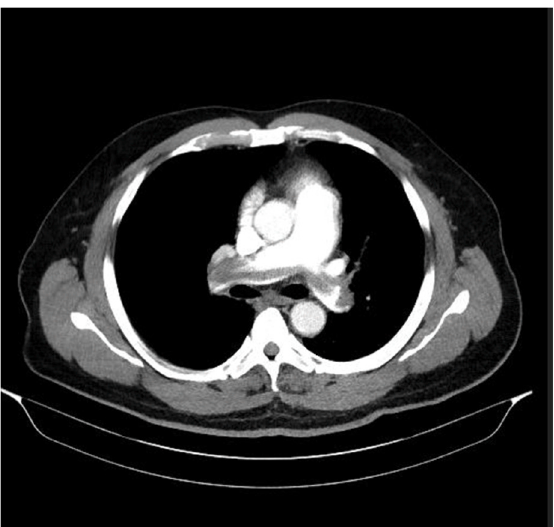
T pattern in lead III. 3 3